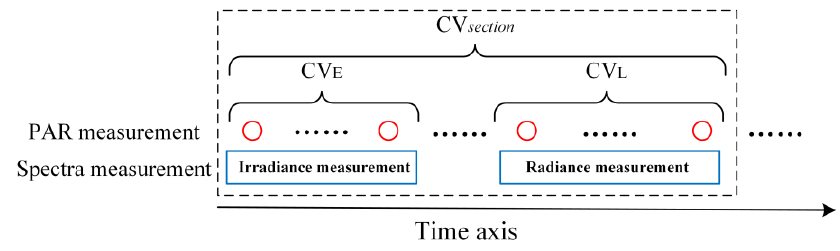
Figure 3. The calculations of CV E , CV L , and CV section . The bottom axis represents time. The red cycles represent the high-frequency PAR measurements of the ML-020P quantum sensor. The blue rectangles represent the spectral measurements of the spectrometer, including the measurements of radiance and